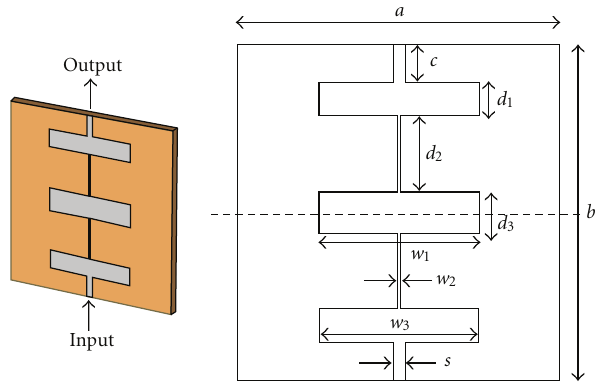
Figure 3: Geometry and design parameters of the low-pass planar